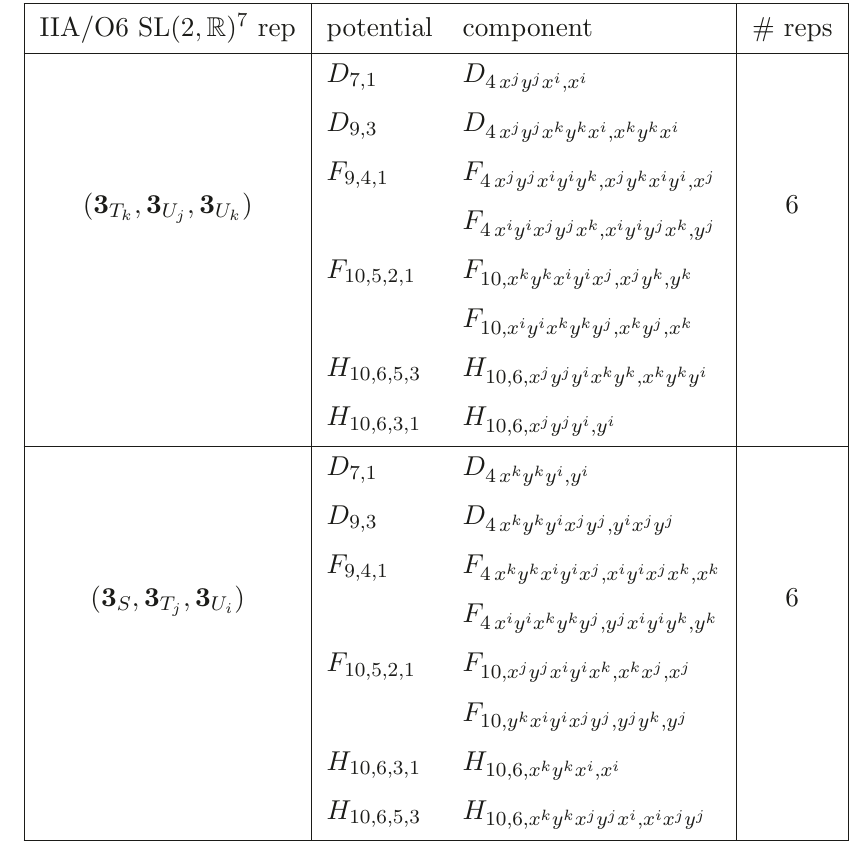
Table 11 . The SL(2 , R ) 7 representations of the forbidden IIA/O6 potentials which couple to space-filling branes with α even. The branes are 96 in number and are embedded in 12 different